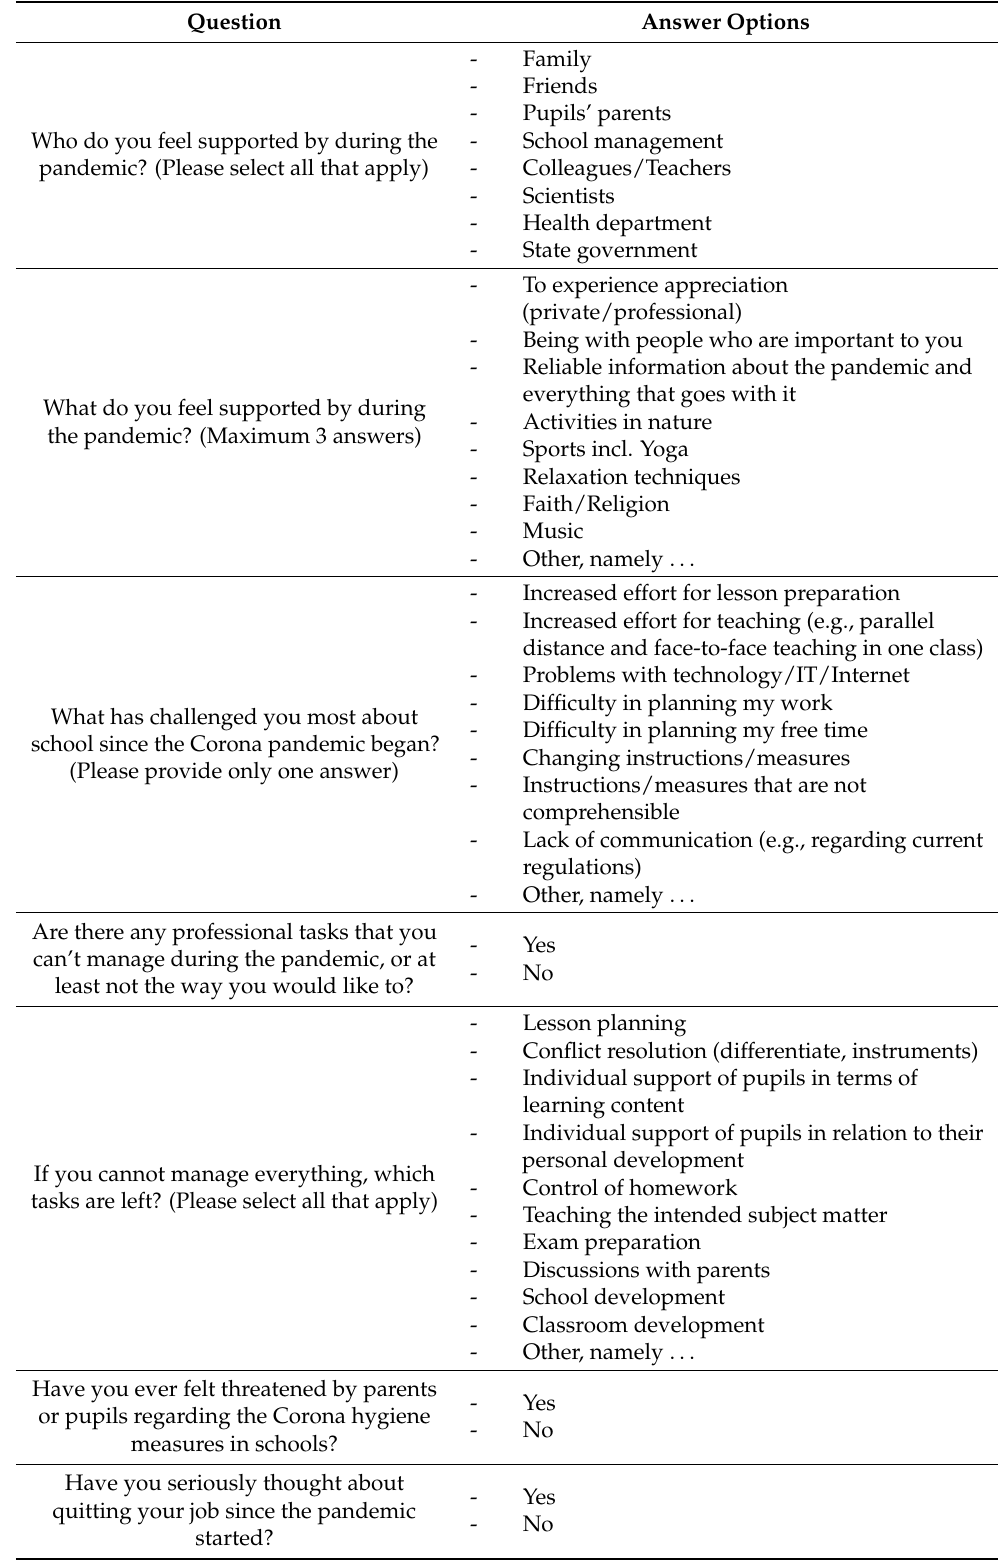
Table 1. Additional questions for teachers and